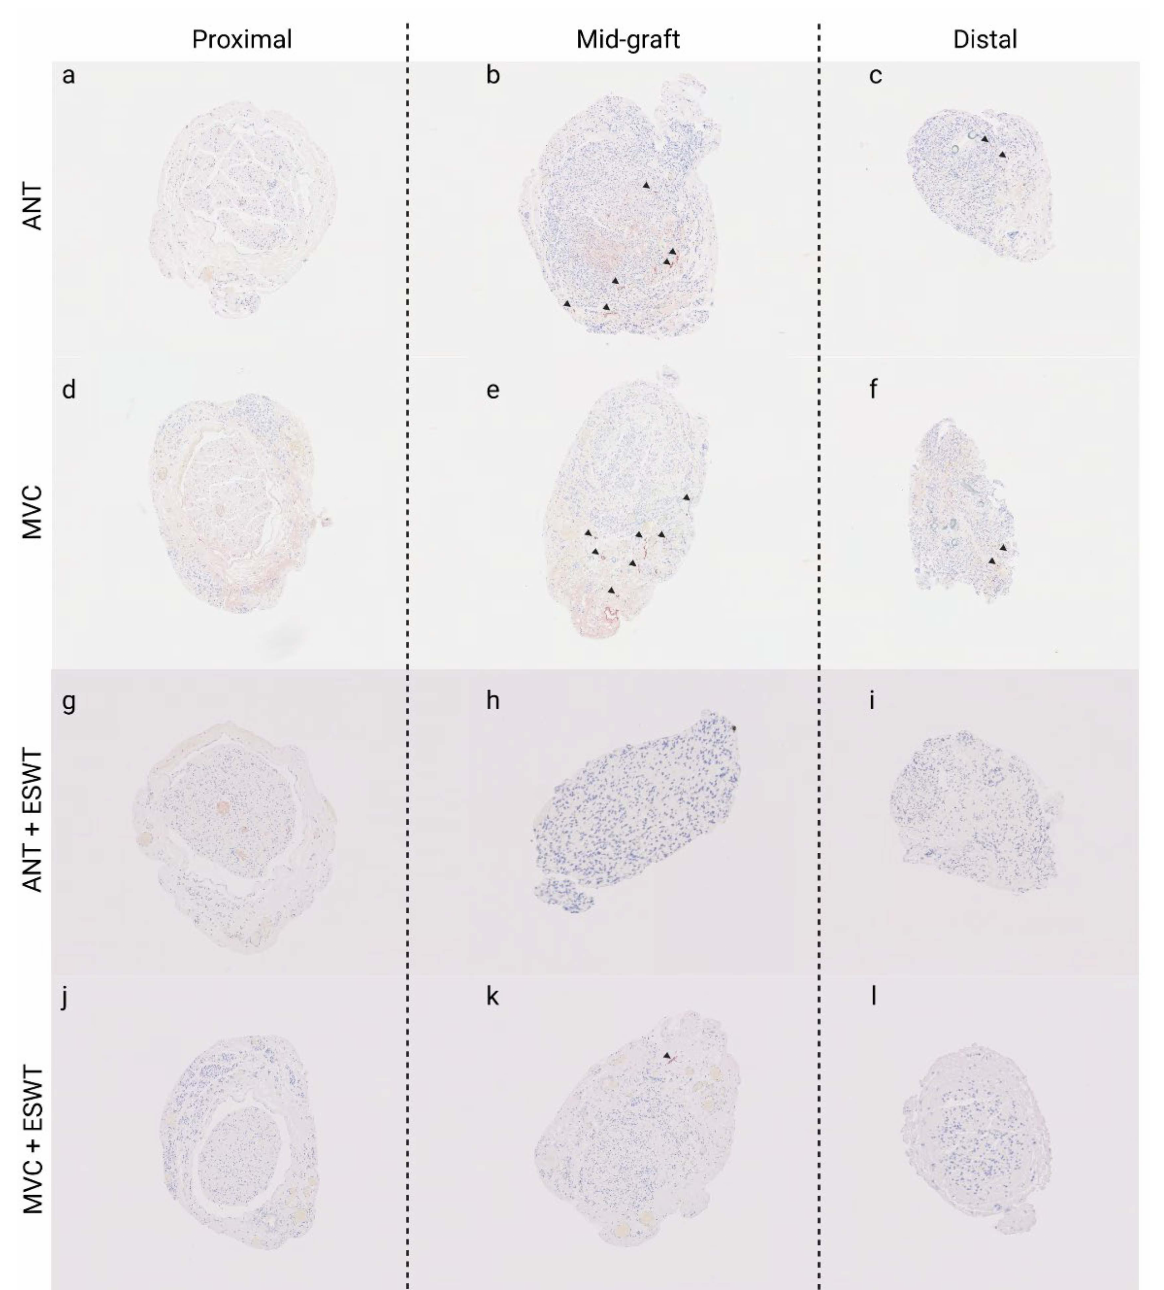
Figure 11. Representative photomicrographs of anti-podoplanin-stained consecutive cross-sections through the regenerated tissue in the proximal nerve segment ( a , d , g , j ), the middle of the nerve graft ( b , e , h , k ) and the distal nerve graft ( c , f , i , l ) at 12 weeks post-surgery. Autologous nerve graft ( a – c ); muscle-in-vein-conduit ( d – f ); autologous nerve graft + extracorporeal shockwave therapy ( g – i ); muscle-in-vein-conduit + extracorporeal shockwave therapy ( j – l ). Scale bar = 200 µ m. Podoplanin- positive stained lymphatic vessels are indicated by